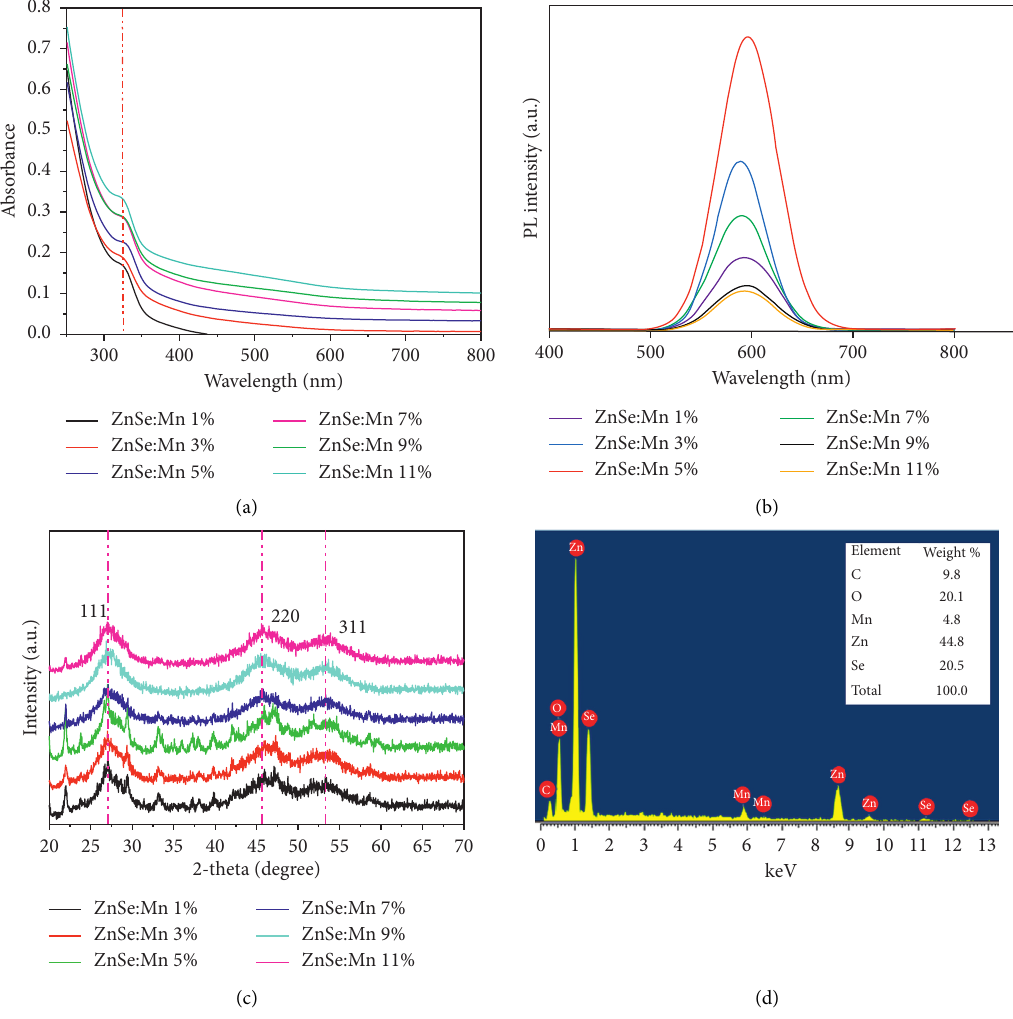
Figure 1: UV-Vis absorption spectra (a). PL emission spectra (excitation wavelength of 350nm) (b). XRD patterns (c) of the ZnSe:Mn core with different Mn concentrations, and the EDX spectrum of the ZnSe:5% Mn sample (d).